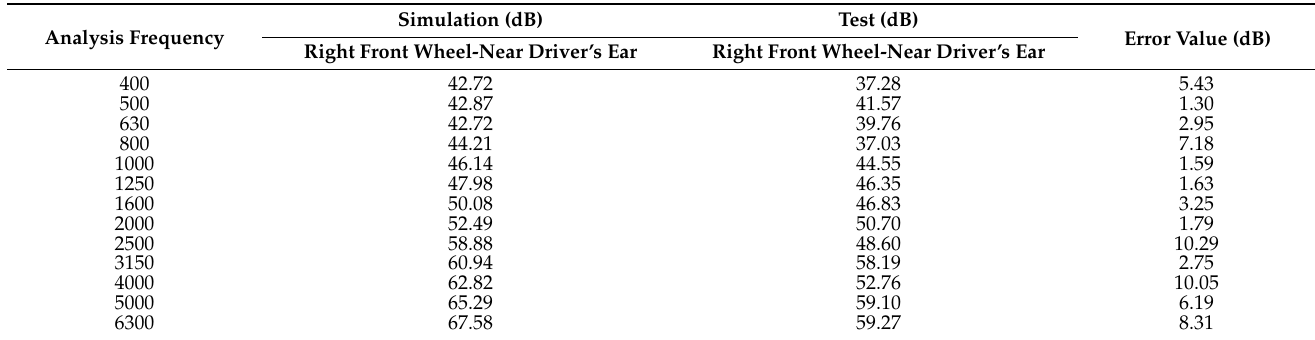
Table 5. Right front-wheel-drive test results.